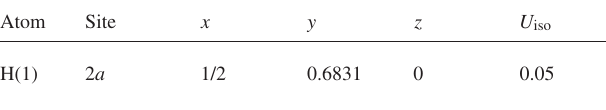
Table 2. Atomic coordinates and displacement parameters (in Å 2 ) .